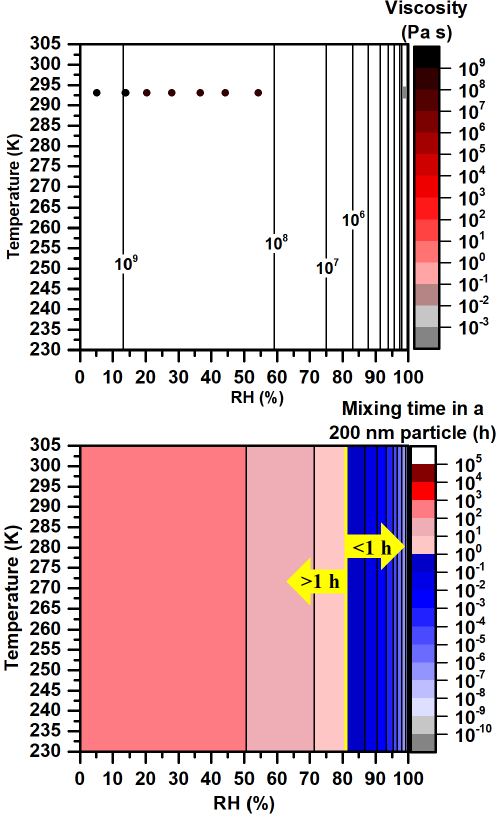
Figure 6. Mixing times of organic molecules within 200nm α - pinene SOA particles at the top of the planetary boundary layer as a function of latitude and longitude in (a) January and (b) July. The colour scale represents mixing times. Mixing times are only shown for locations with total organic aerosol concentrations > 0 . 5µgm − 3 at the surface. The viscosity parameterization used to calculate mix- ing times were based α -pinene SOA generated using mass concen- trations of ∼ 1000µgm − 3 .